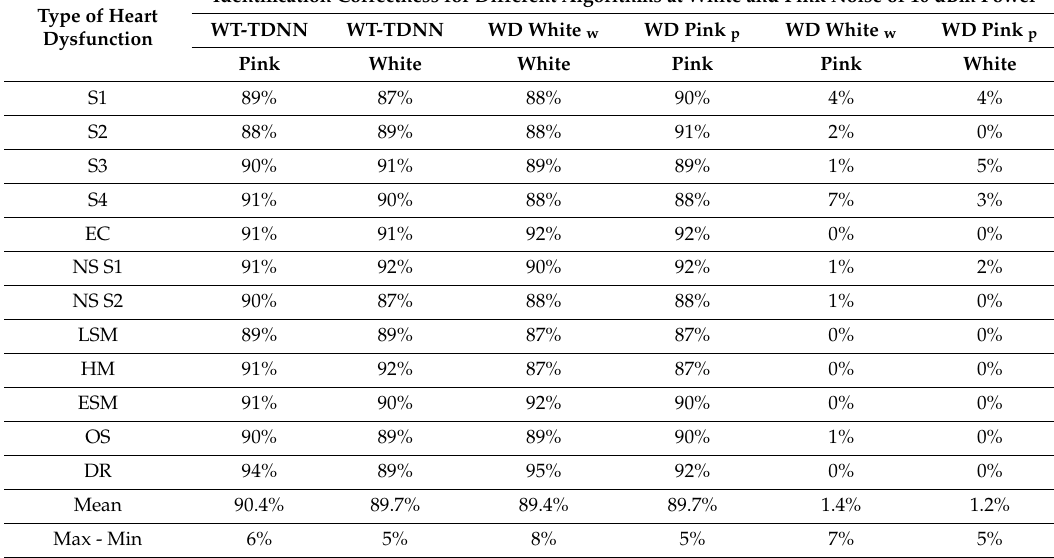
Table 4. Comparison of the identification correctness for different algorithms at white and pink noise of 10 dBm power using following denoising methods: WD white w , WD pink p , and WT-TDNN. Type of Heart